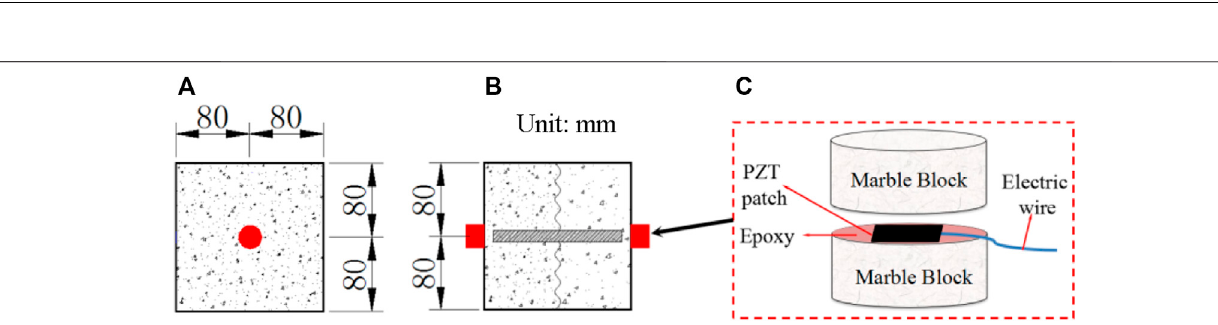
FIGURE3| Theproductionprocessanddimensionsofthespecimens. (A) Pouring theoldconcrete; (B) Implantingtherebarintotheoldconcrete; (C) Pouringthe new concrete (units mm); (D) The old-new concrete specimen.